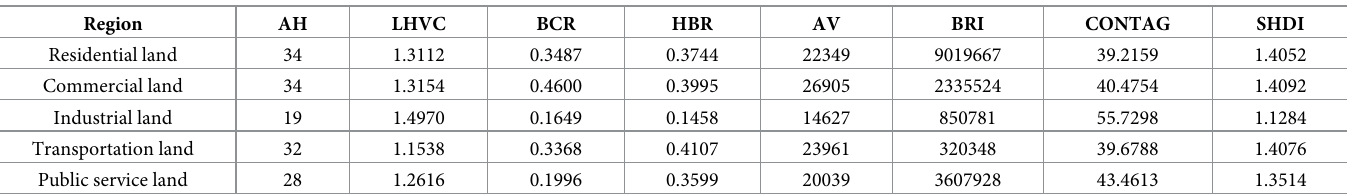
Table 4. Architectural landscape index values for each functional